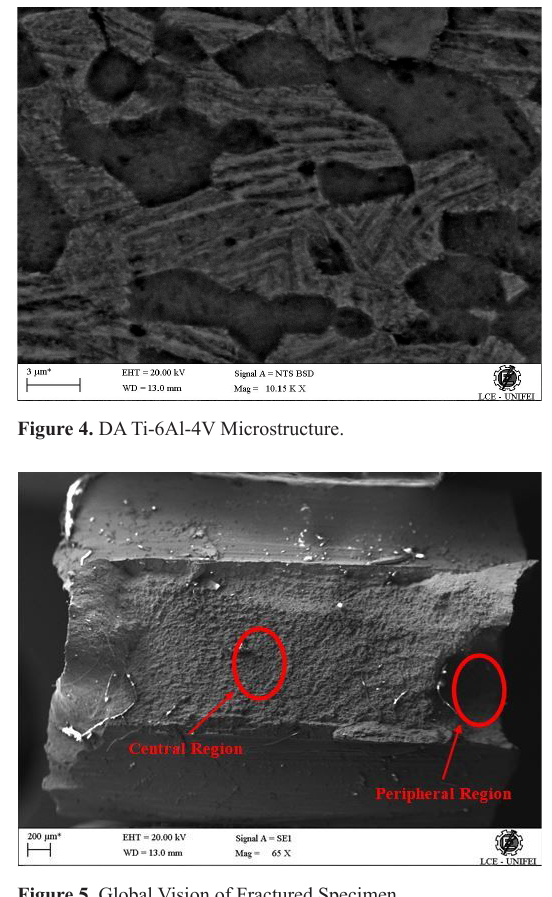
Figure 5. Global Vision of Fractured Specimen.